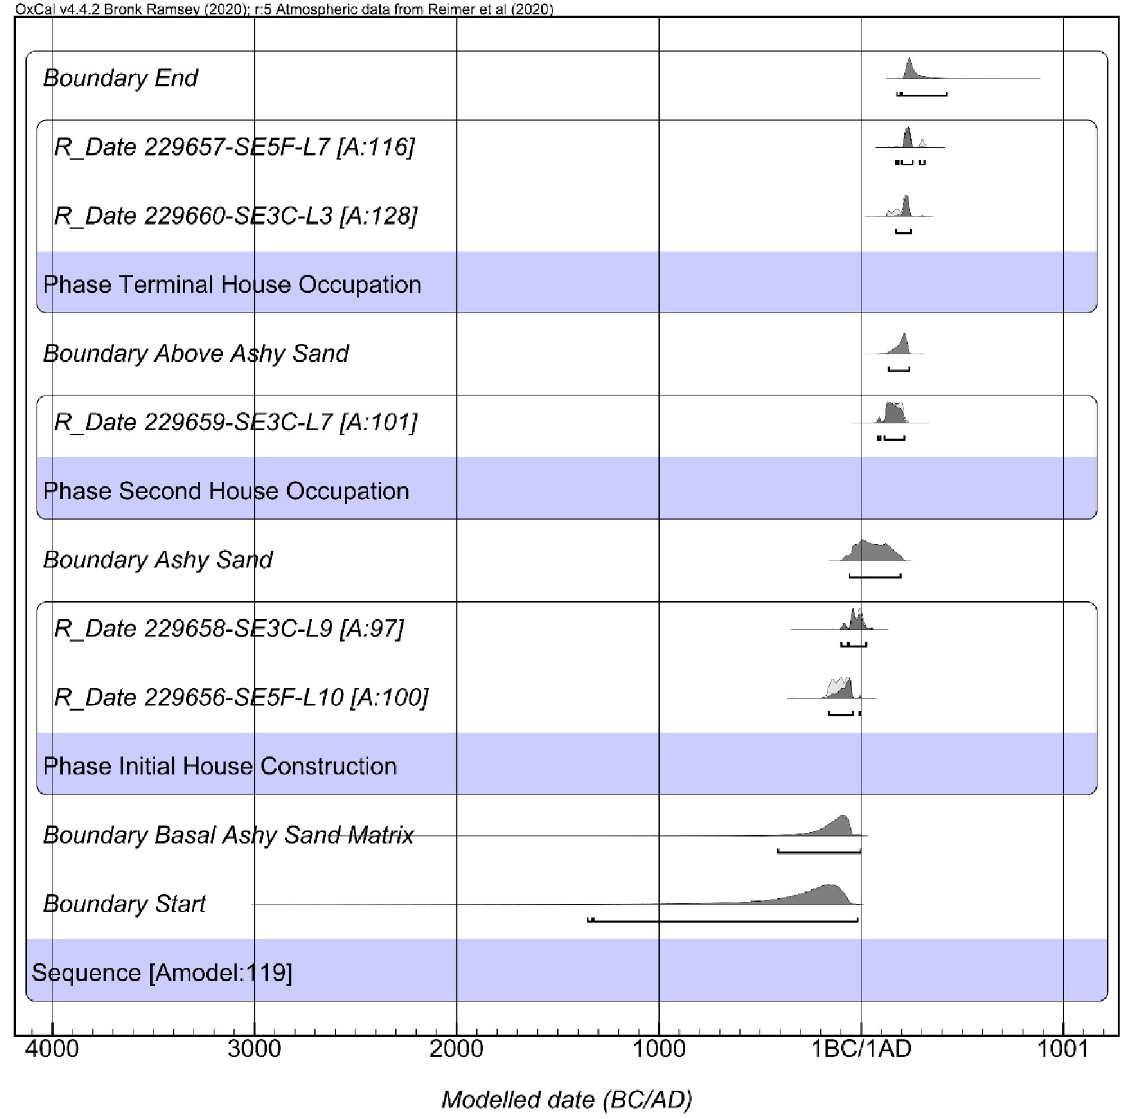
Fig 10. Results of the fourth iteration of the Palmrose chronological